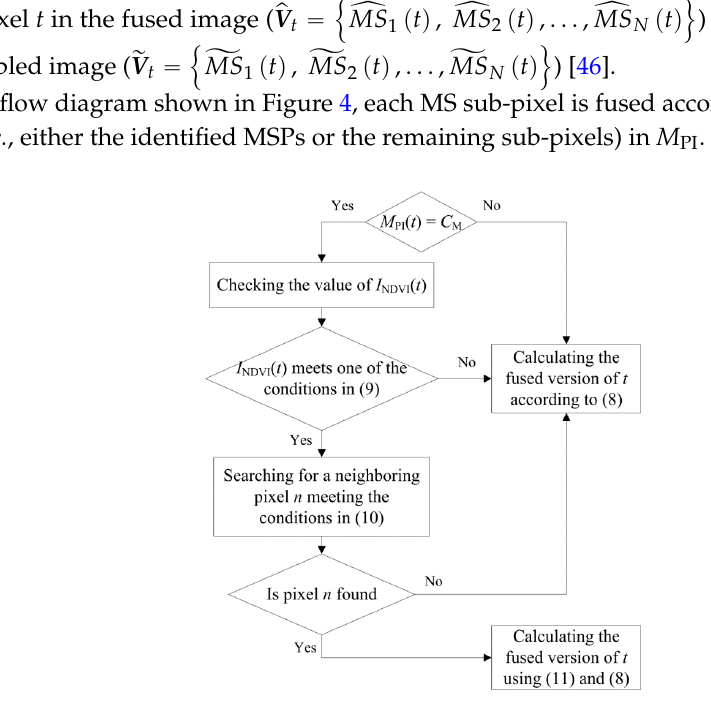
Figure 4. The flow diagram for the fusion of the MS sub-pixels.